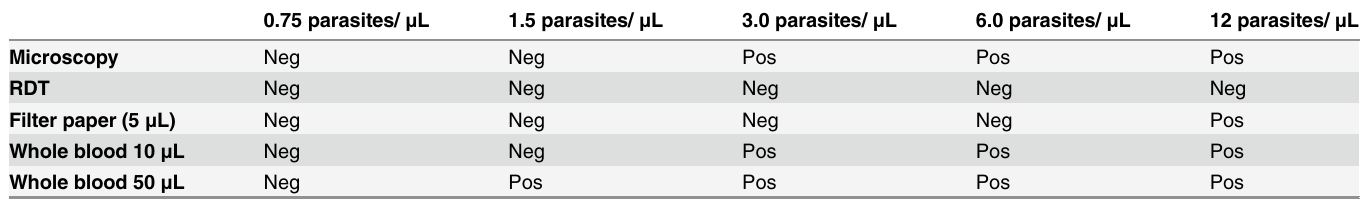
Table 5. Comparing microscopy and RDT with the limit of detection of HtLAMP-Pv using filter paper and whole blood at 10 μ L and 50 μ L volumes.